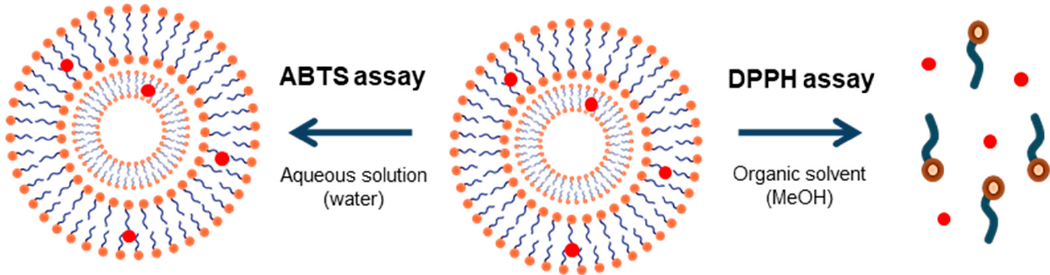
Figure 4. Organization of amphiphilic molecules in the antioxidant assays.